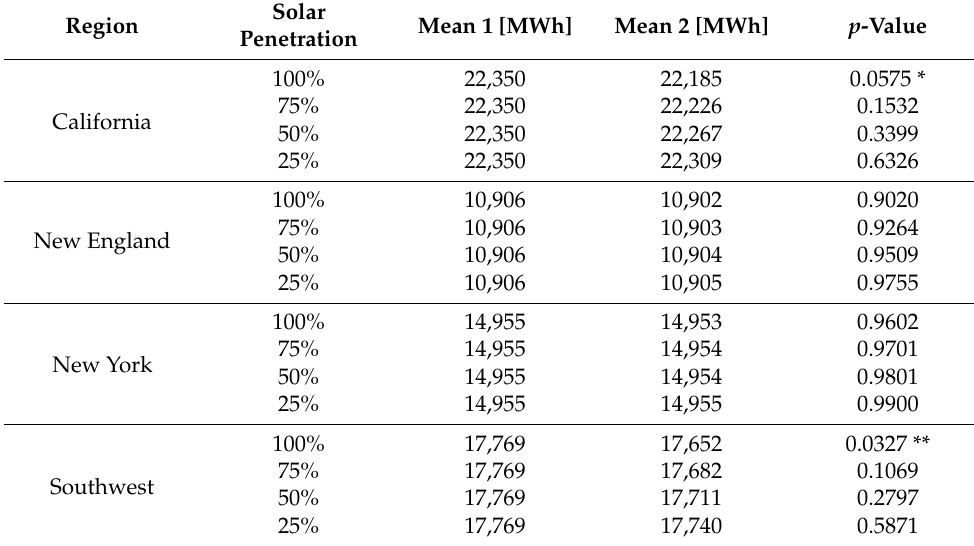
Table 7. Hypothesis 1— t -test results by region and level of solar